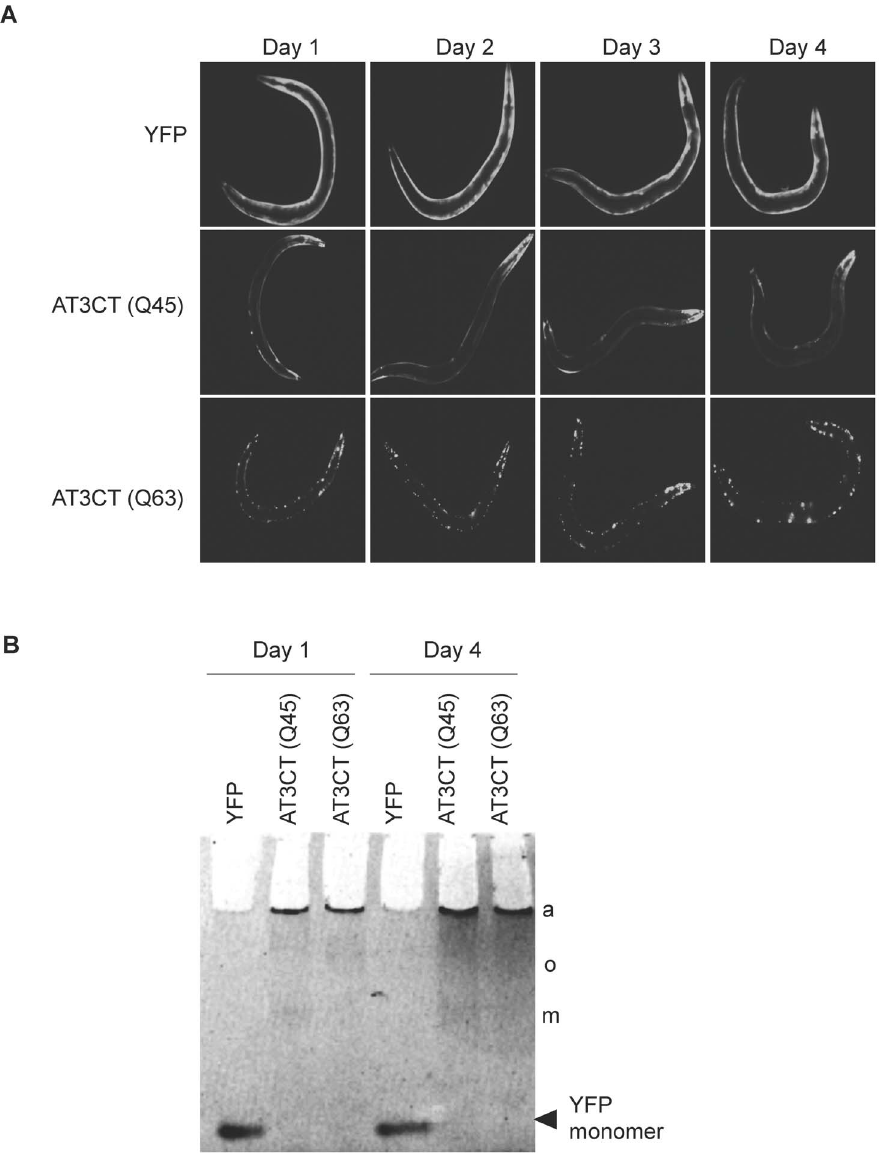
Figure 4. Effect of aging on AT3CT aggregation. A. Micrographs showing YFP fluorescence in YFP- or AT3CT(Q45 or Q63)-expressing animals. B. Native gels showing the relative distribution of presumptive monomers (m), oligomers (o), and aggregates (a) at day 1 as compared to day 4